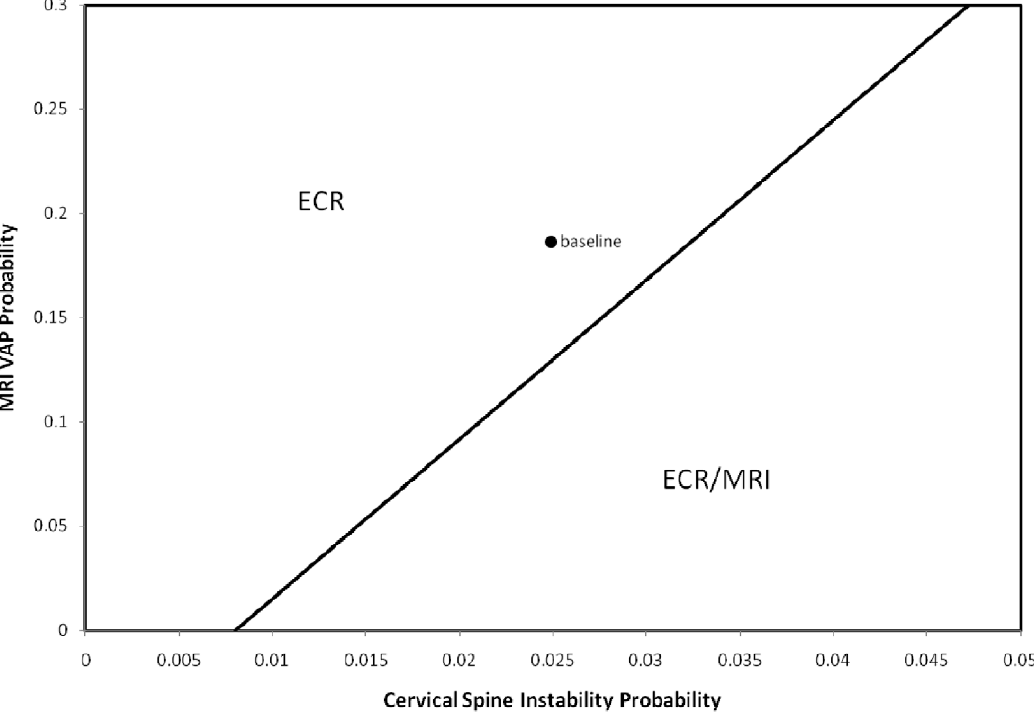
Figure 3. Two-Way Sensitivity Analysis, MRI VAP Probability vs. Cervical Spine Instability Probability in the Stable category of TBI,